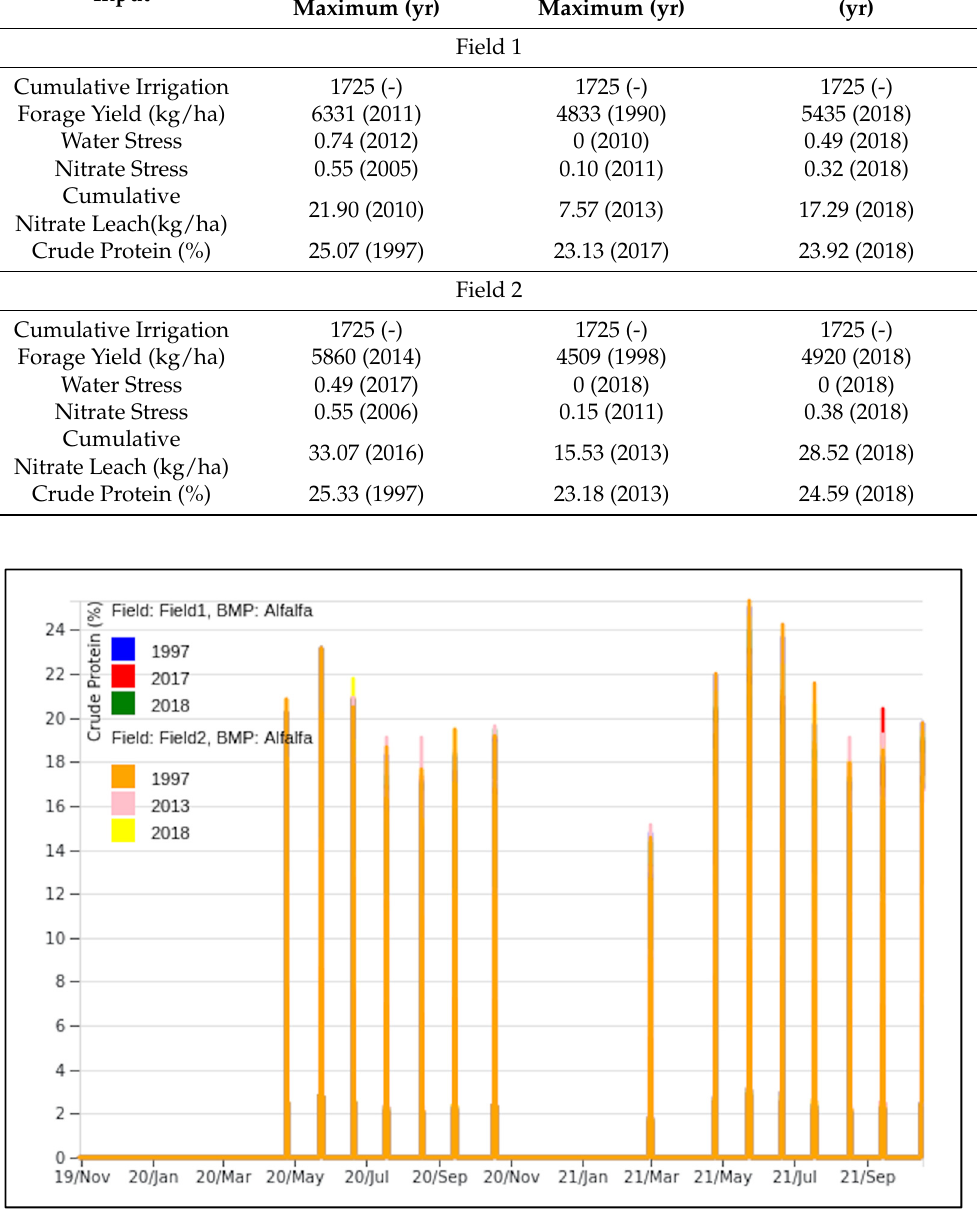
Figure 9. Crude Protein for Field 1 (near Tulare, California) and Field 2 (near Davis,